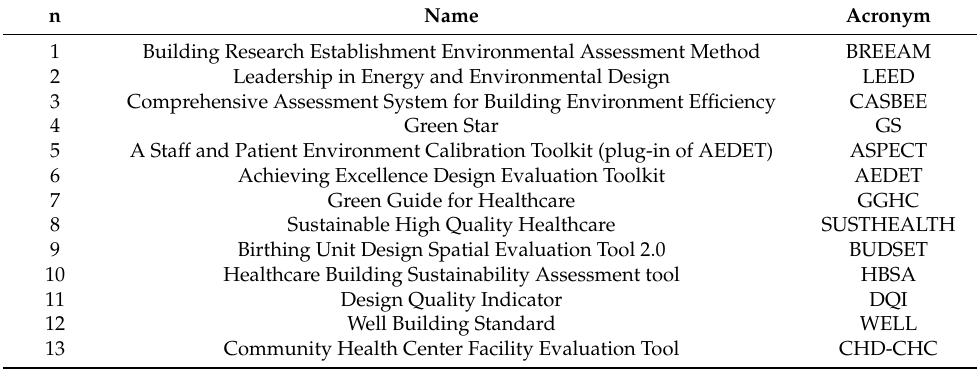
Table 2. List of tools included in the review and their acronyms used in the following paragraphs. n